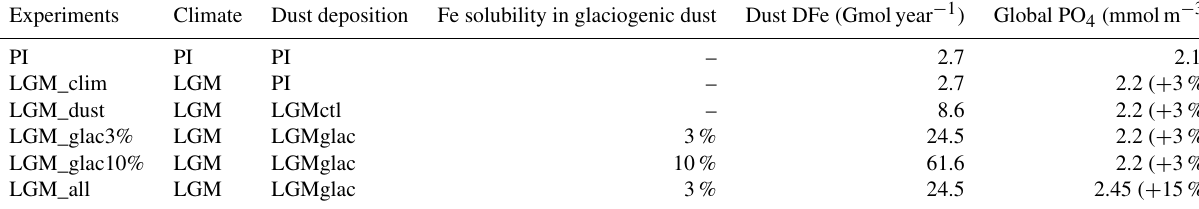
Table 1. Description of the model experiments.